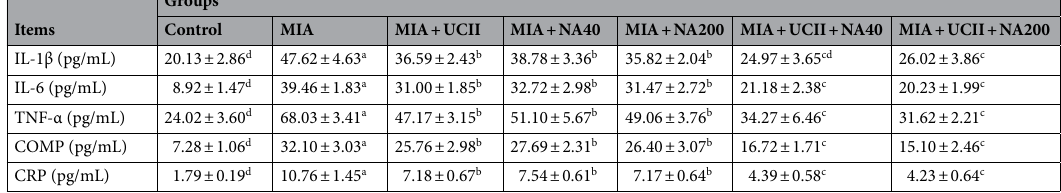
Table 4. Effects of niacinamide (NA) and undenatured type II collagen (UCII) supplementation on serum inflammation parameters in rats (n = 7). Data are presented as mean and standard deviation (p > 0.05; ANOVA and Tukey’s post-hoc test). NA: niacinamide; MIA: monosodium iodoacetate; UCII: undenatured type II collagen; IL-1β, Interleukin 1 beta; IL-6, Interleukin 6; TNF-α, tumor necrosis factor-alpha; COMP, cartilage oligomeric matrix protein; CRP, C-reactive protein. NA40 and NA200 represent 40 and 200 mg/kg niacinamide dose applications, respectively. (a–d): Means in the same line without a common superscript differ significantly.